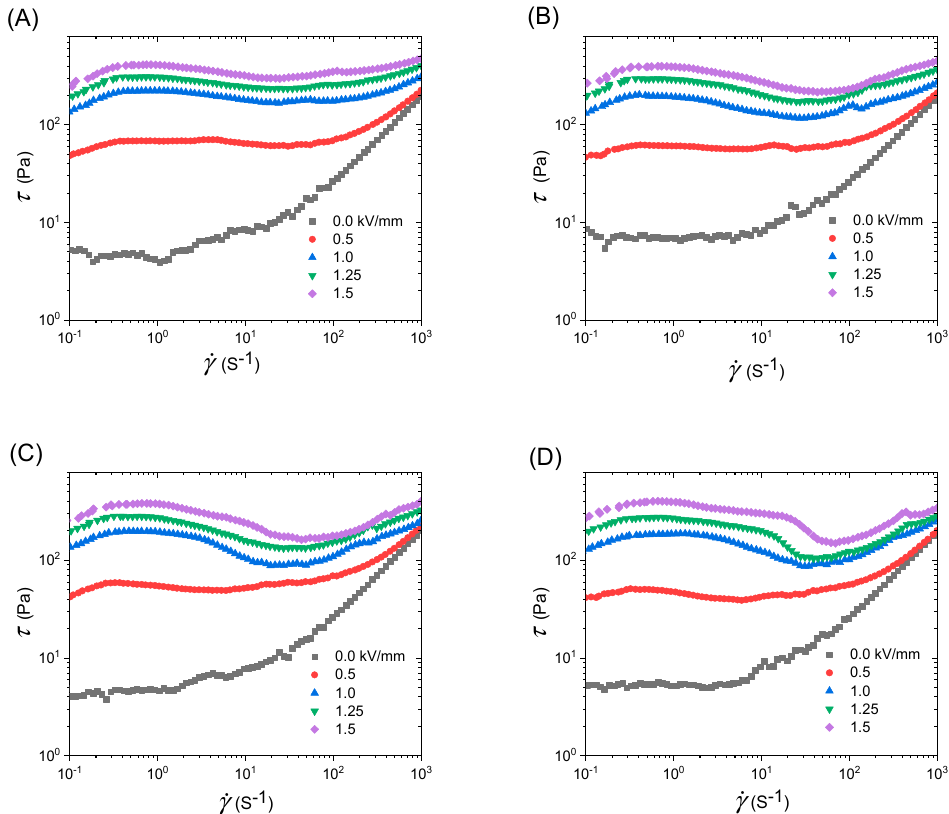
Figure 6. Flow curves of the shear stress-shear rate of ERFs of PEANI/rGO obtained by reduction with different amounts of hydrazine: ( A ) 70 μ L, ( B ) 140 μ L, ( C ) 420 μ L, ( D ) 1400 μ L ( T = 25 °C).